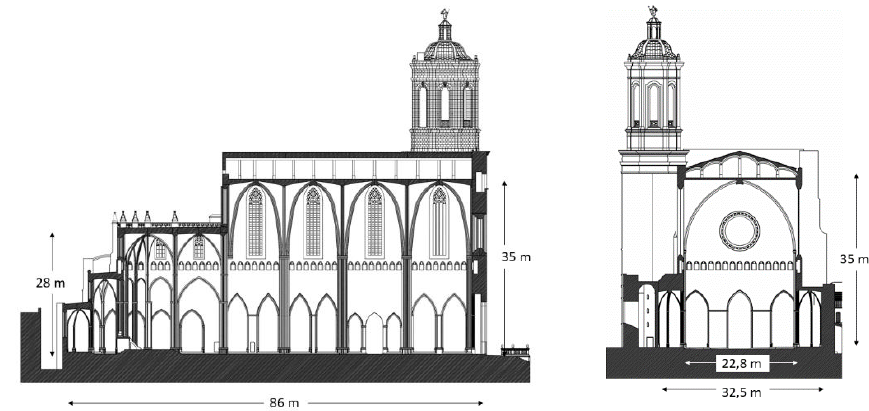
Figure 3. Section of the Girona Cathedral. Source: Girona Cathedral Archive.